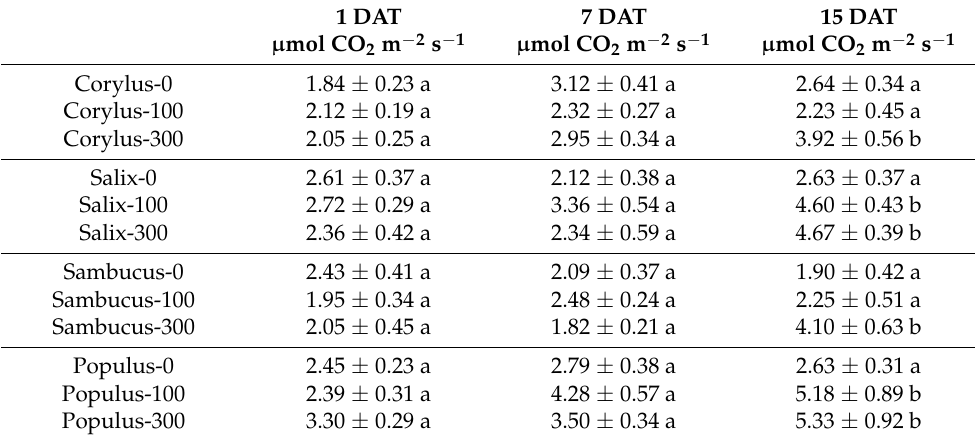
Table 1. Leaf net photosynthesis (Pn) of the leaves of Corylus , Salix , Sambucus , and Populus treated with the three NO 3 − concentrations in hydroponic nutrient solution at 1, 7, and 15 days after the treatment (DAT).